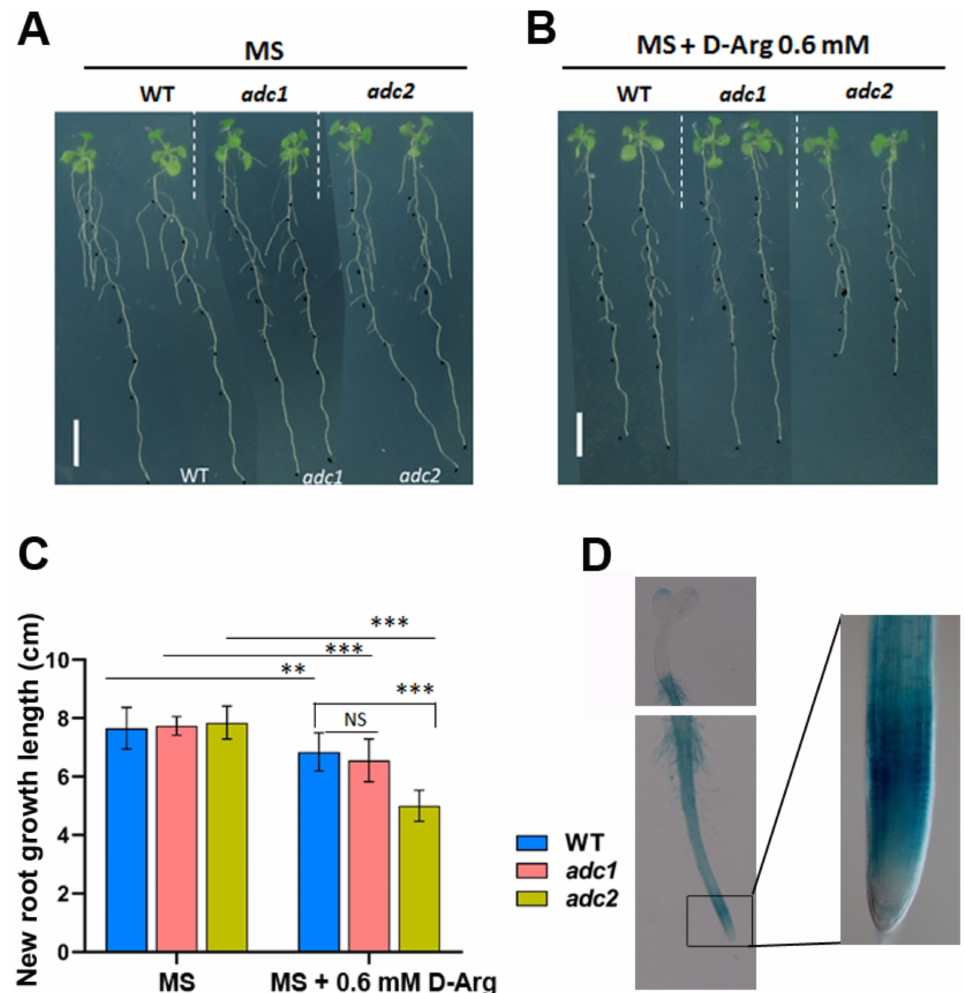
Figure 1. adc1 and adc2 single mutants exhibit no root phenotype and the results indicate that ADC2 localizes mainly to the root and adc2 is more sensitive to D-Arg than adc1 . For ( A ), ( B ) and ( C ), 5-day-old seedlings at the same developmental stage were transferred to new media containing water (Ctrl) or 0.6 mM D-Arg and were treated for 8 days. ( A ) Untreated wild-type (WT), adc1, and adc2 root phenotypes are the same. Scale bar = 1 cm. ( B ) D-Arg treatment inhibits root length of WT, adc1 , and adc2 . Scale bar = 1 cm. ( C ) D-Arg treatment exhibits no difference between WT and adc1 root length; however, the adc2 root is significantly shorter that of WT and adc1 phenotypes. ( D ) Histochemical localization of GUS activity in 2-day-old transgenic seedling harboring promoter ADC2::GUS ( pAtADC2::GUS ). Data shown are averages ± SD (n > 30). Asterisks denote significant differences (** p < 0.01, *** p < 0.001; Student’s t